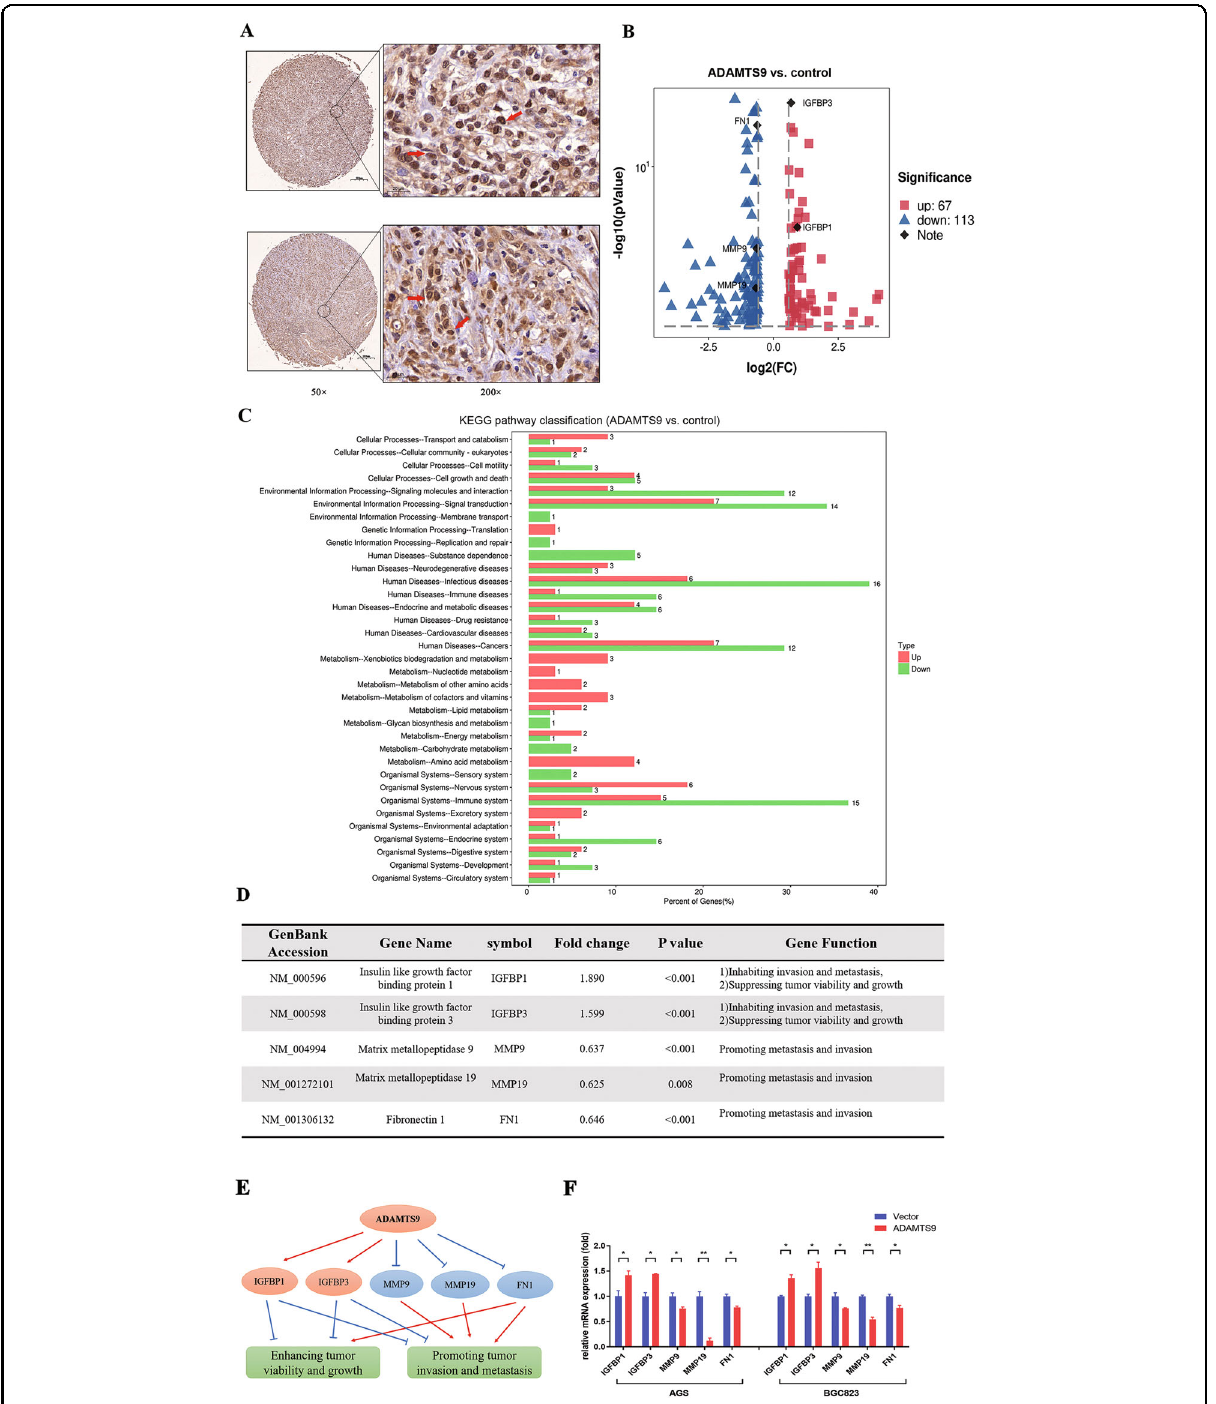
Fig. 3 Downstream molecular of ADAMTS9 in GC were identi fi ed by using the RNA-sequencing method. A ADAMTS9 is enriched in the nuclei of gastric mucosal cells. B , C The volcano plots and KEGG enrichment plots were generated from mRNA sequencing analysis of ADAMTS9- overexpressing BGC-823 cells and control cells transfected with empty plasmid. D , E Downstream potent molecular events were identi fi ed for impairing viability, proliferation, and motile capacity. F The downstream DEGs were validated by the qPCR in AGS and BGC-823